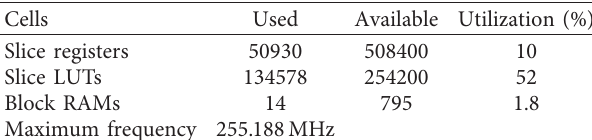
Table 3: Summarization of synthesis results.